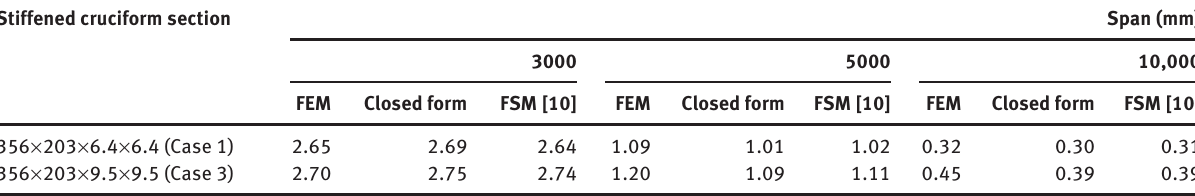
Table 14 Effect of the vertical (or horizontal) stiffener thickness on the normalized critical buckling